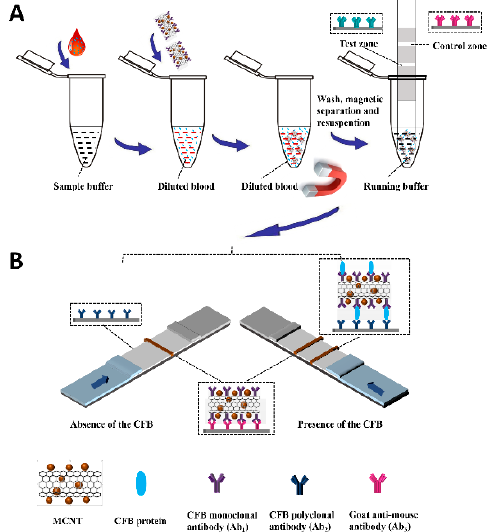
Figure 2. ( A ) Schematic representation of the strategy of detecting complement factor B (CFB) with MCNT-based lateral flow immunoassay (LFI); ( B ) the principle of detecting CFB with LFI in the absence and presence of CFB.